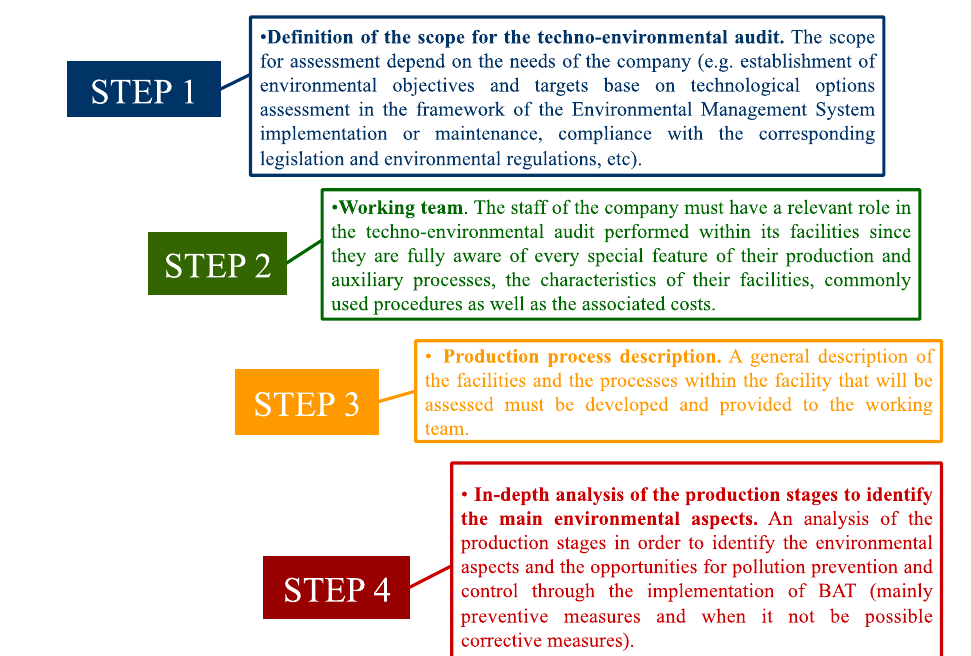
Figure 8 . Several steps to guide the SP Operational practice users towards the identification of the BAT applicable in the production